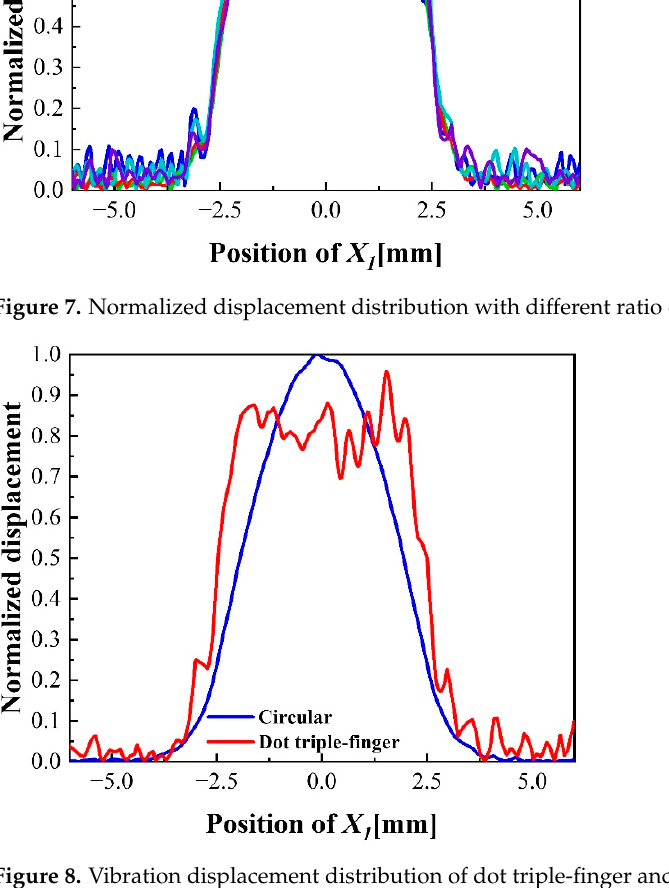
Figure 9. Photograph of the fabricated the QCM with double-finger electrode. Table 1. Dimensions of quartz crystal and double-finger electrode. Object